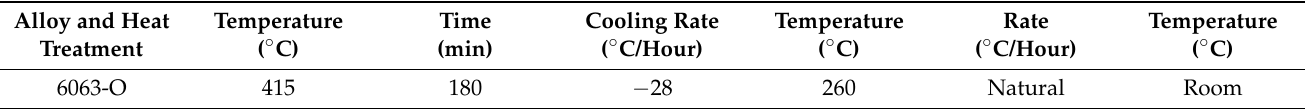
Table 2. Parameters of the homogenization annealing of AA6063